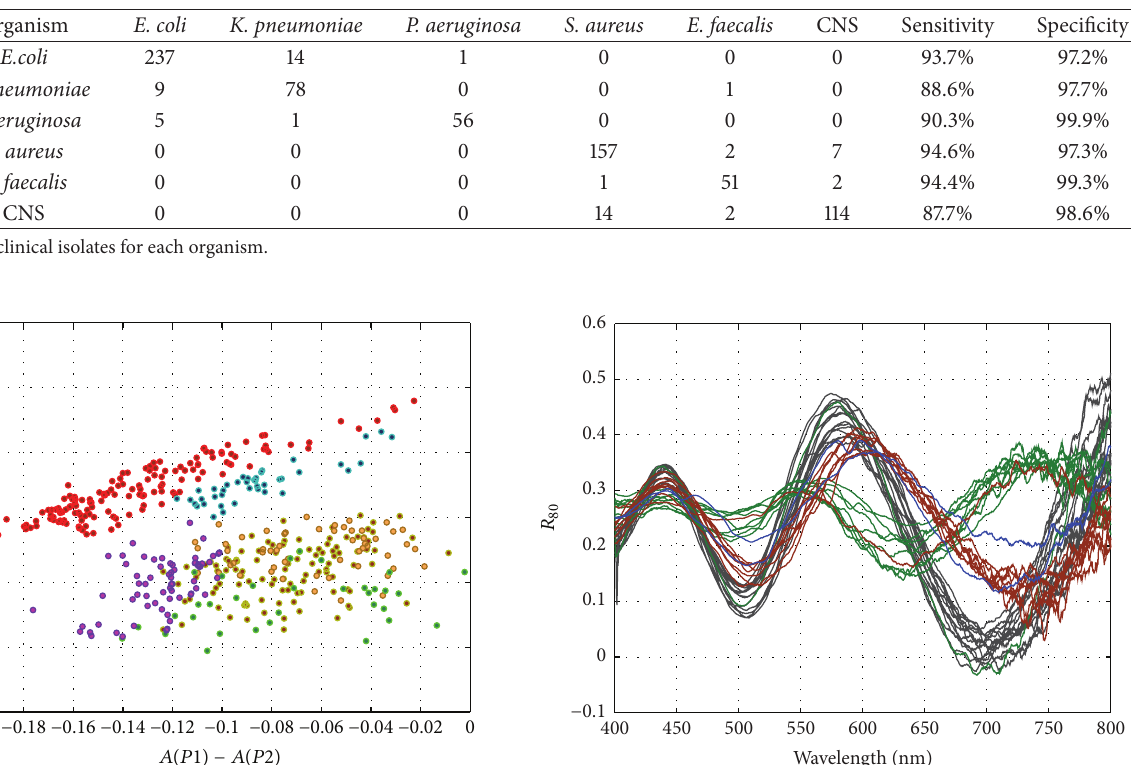
Table 5: Sensitivity and specificity results for the identification assignment of clinical isolates using combination of transmission and angular scattering identification models.